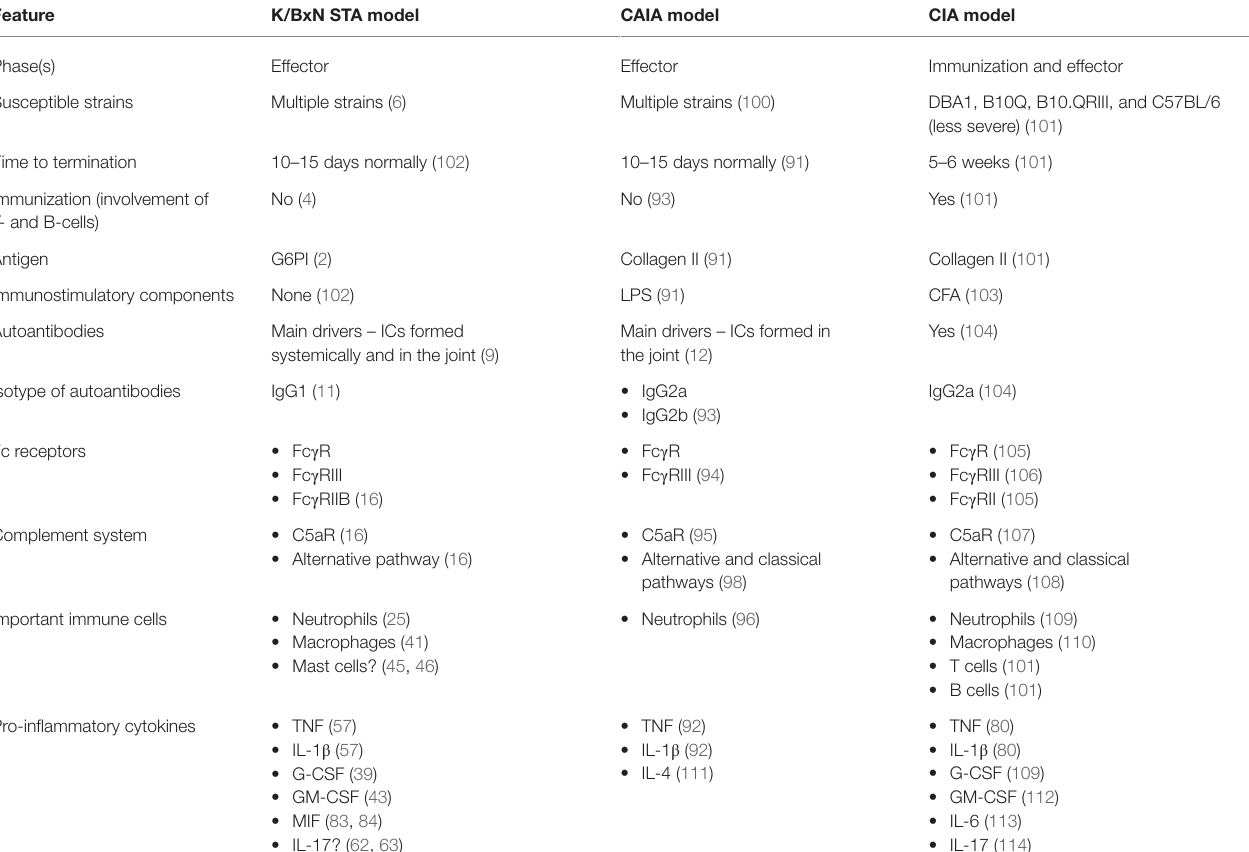
TABLe 1 | Similarities and differences between the K/BxN STA, CAiA, and CiA